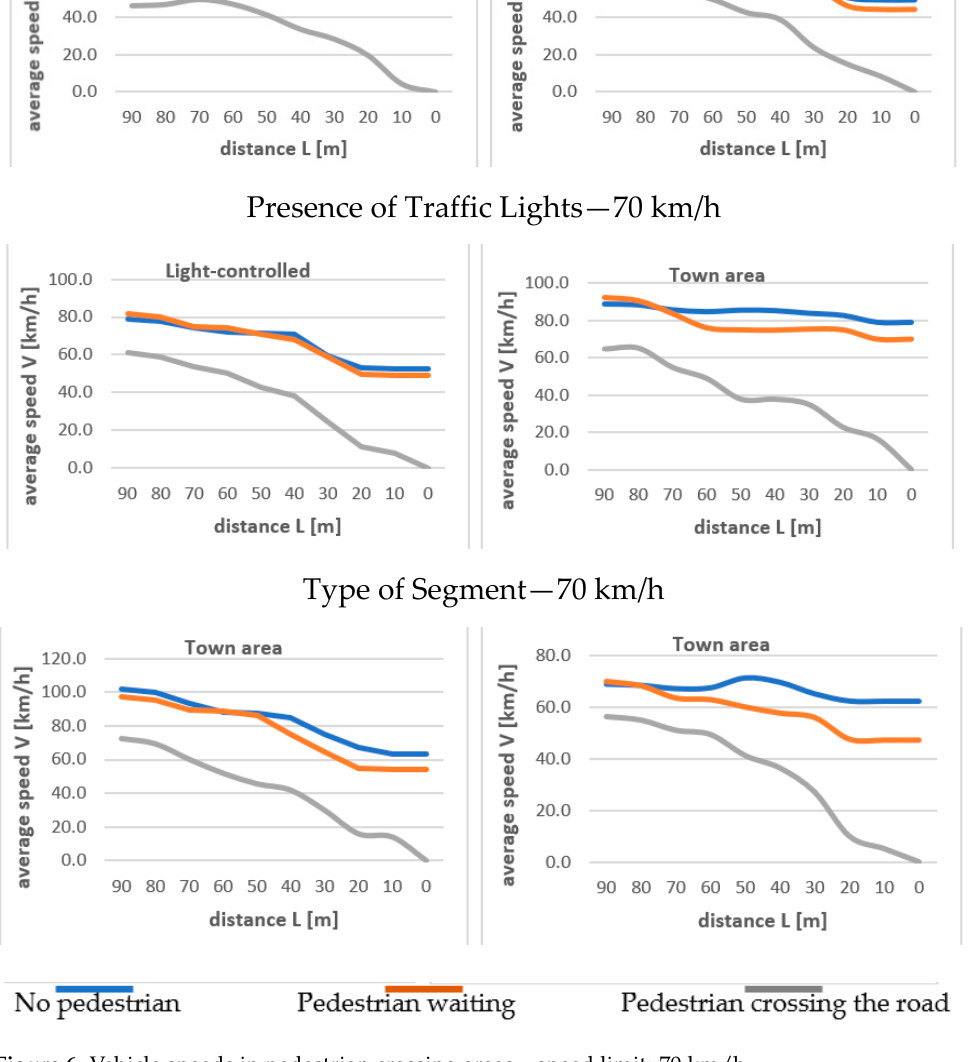
Figure 6. Vehicle speeds in pedestrian crossing areas—speed limit: 70 km/h.